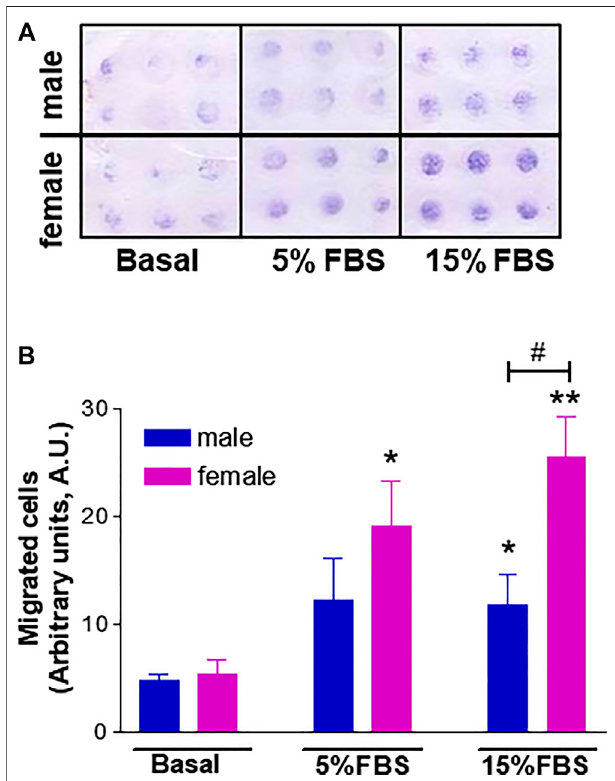
FIGURE 4 | Effect of donor ’ s sex on HUVEC migration in a chemotaxis assay using 5% or 15% FBS as a chemoattractant agent. (A) . Representative image of HUVEC migration in a modi fi ed 48-well Boyden chamber after 6 h incubation at 37 ° C. (B) . Cell migration is shown as optical density values (A.U., arbitrary units). Each independent experiment ( n (cid:1) 4) was performed in sextuplicate using cells from one male and one female donor. Data are expressed as mean ± SEM. t -test; * p < 0.05, ** p < 0.01 (vs. basal); # p <